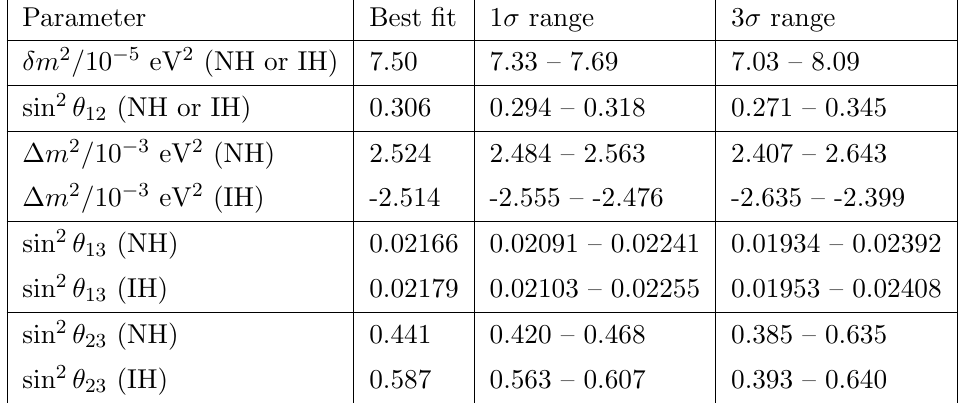
Table 1 . Neutrino mass-squared di(cid:11)erences and mixing angles from global analysis of solar, atmo- spheric, reactor and accelerator data [11]. Note that NO (cid:23) A data is not included in this